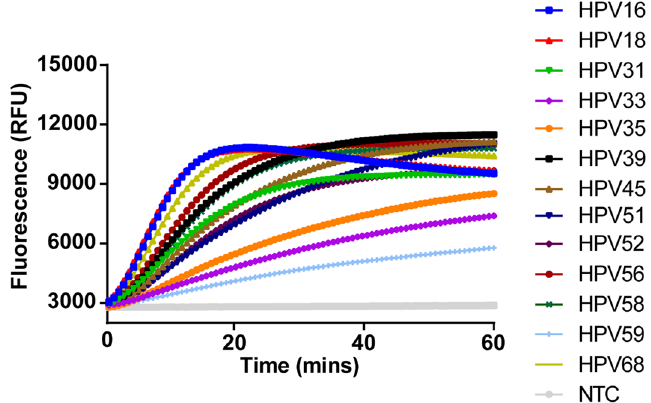
Figure 3. Evaluation of the enhanced PGMY/GP6+ primer pool. The PGMY/GP6+ primer pool was supplemented with additional four primers that have less mismatches to HPV31, 39, 51, 56, 59, 68. The new pool was tested using 10,000 copies of plasmid for each RPA reaction. NTC no-template control.